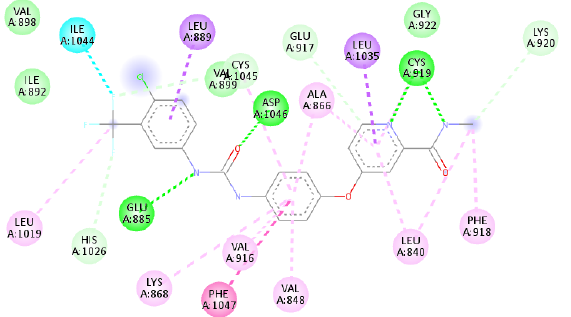
Figure 3. 2D interaction of sorafenib with the VEGFR2 active binding site.